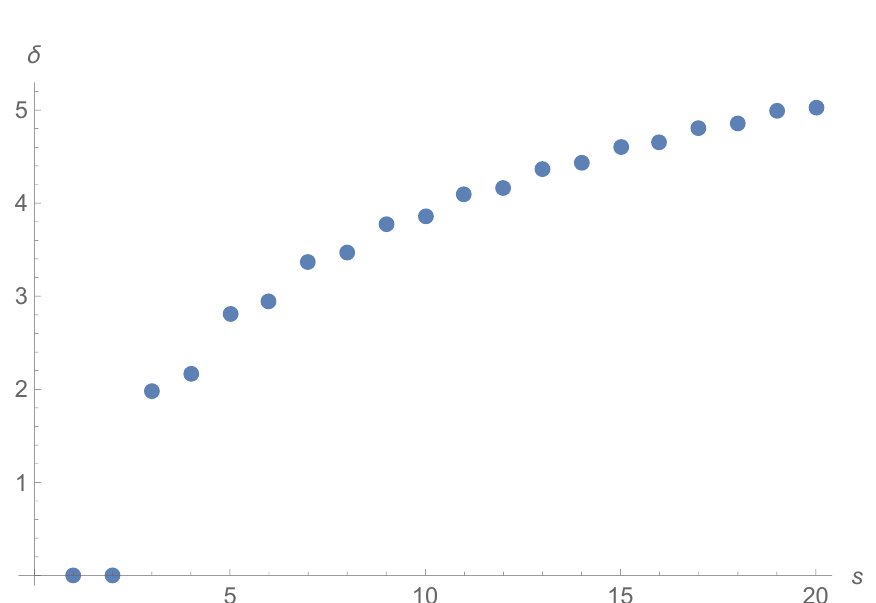
Figure 8 . Anomalous dimensions of the current as a function of spin, in the strong coupling limit, (to be multiplied by M=N ).